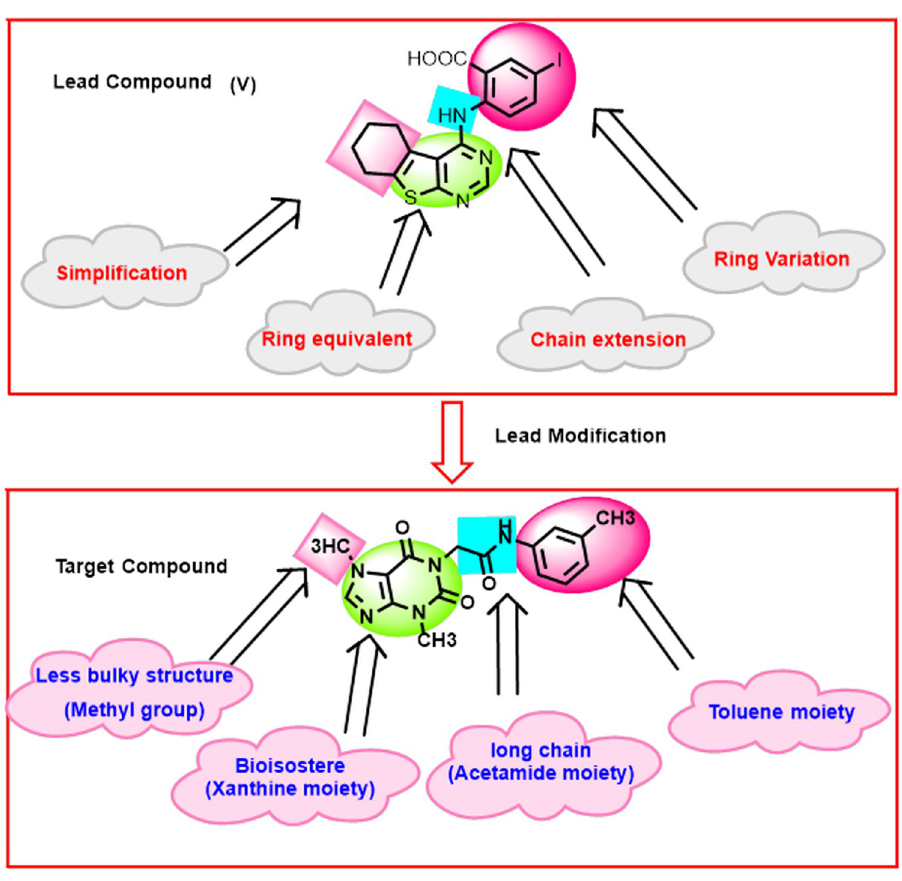
Fig 2. T-1-MTA’s design